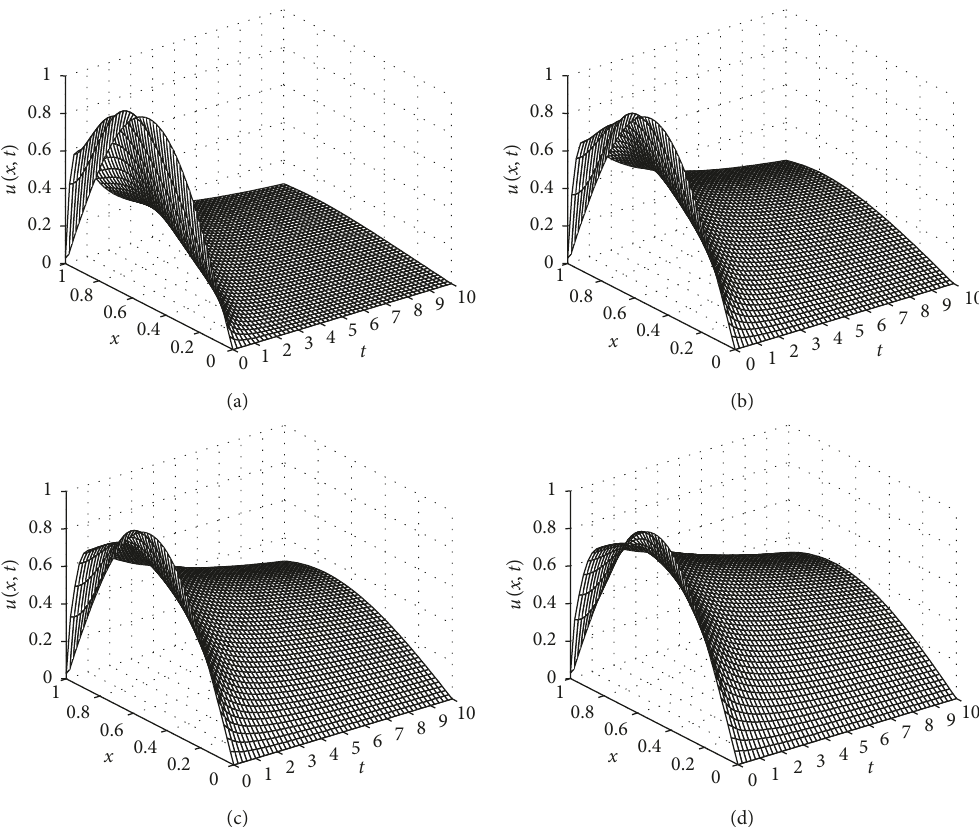
Figure 5: A 3D view of the dynamics of the MGKdVB equation utilizing the second nonlinear adaptive controller ] � 0 . 01, μ � 0 . 001, � 0 . 0005, r � 0 . 2, r � 0 . 2, and u ( x ) � sin ( π x ) . (a) α � 1; (b) α � 2; (c) α � 3; (d) α � 4. c 2 1 2 0